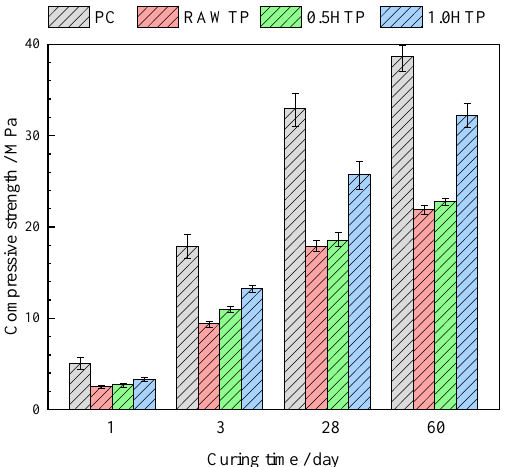
Figure 12. Compressive strengths of cementitious pastes.